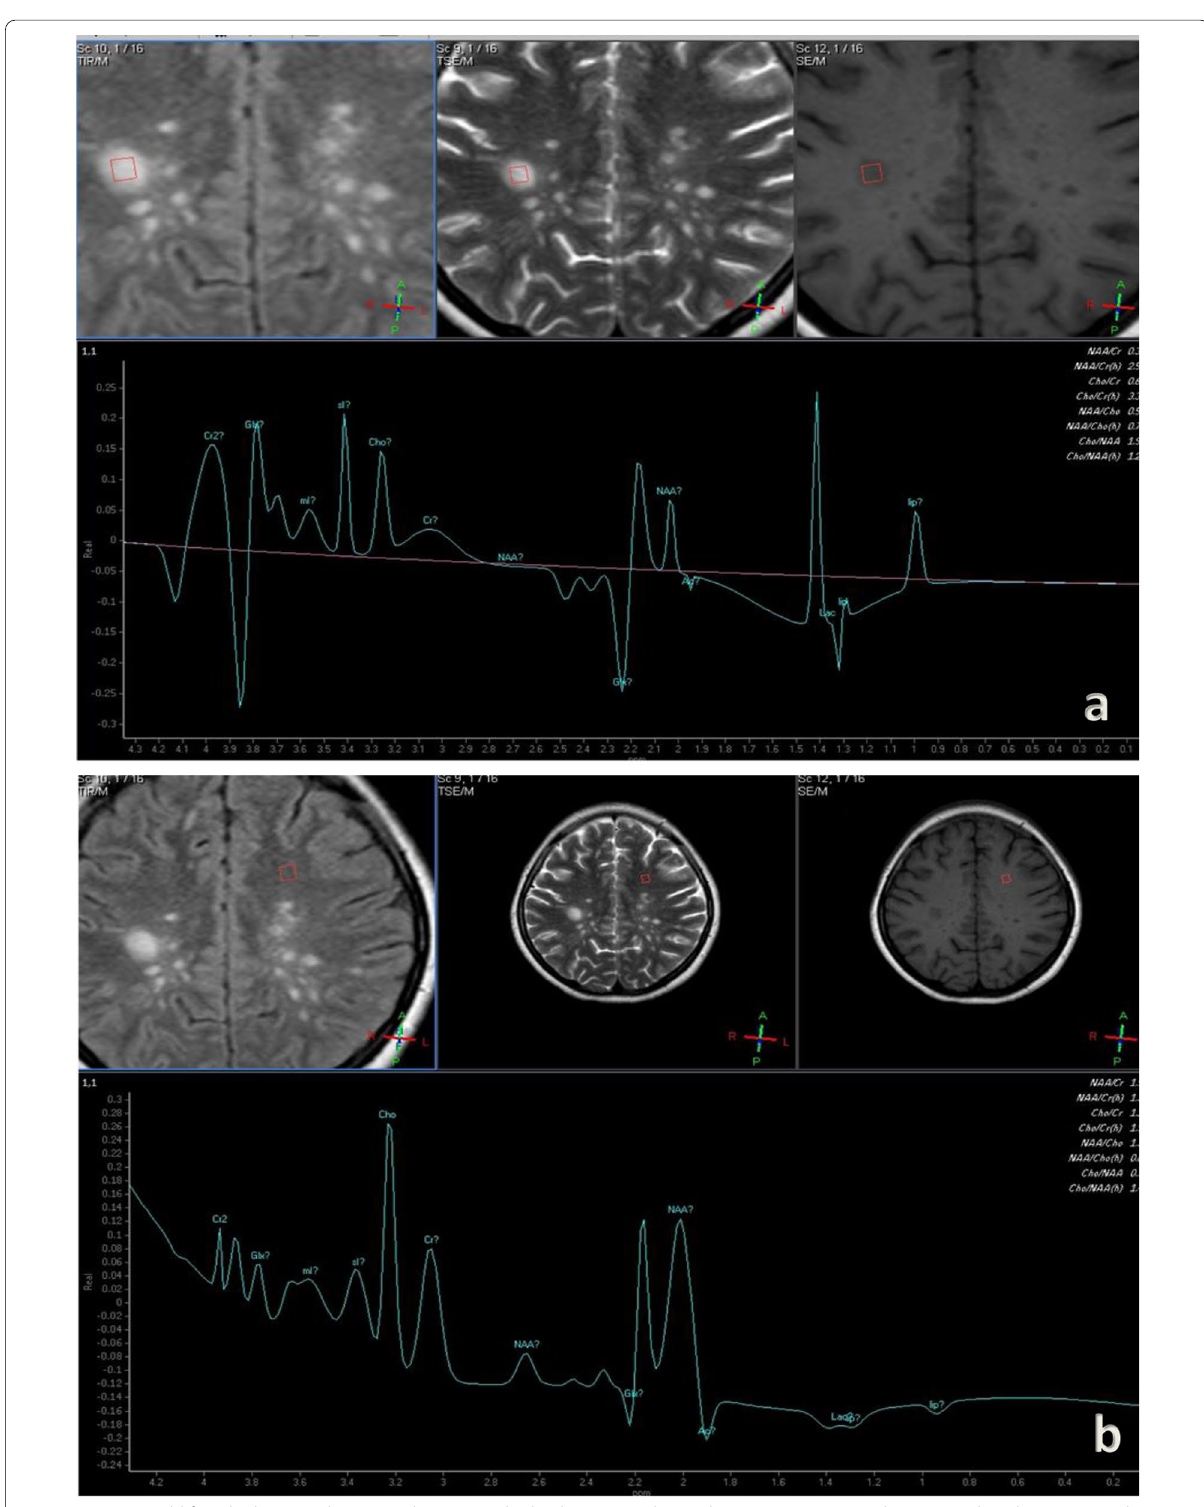
Fig. 3 A 37‑year‑old female diagnosed at RRMS showing multiple plaques; single voxel MR spectroscopy with ROI was placed at corona radiata plaque a ; showing decreased NAA curve and mildly elevated choline curve, which is correlated by Low NAA/Cr ratio 1.44 and elevated choline/Cr ratio 1.06. b ROI placed at NAWM, more lateral to the plaque showing decreased NAA curve and mildly elevated choline curve, which is correlated by Low NAA/Cr ratio 1.45 and elevated choline/Cr ratio